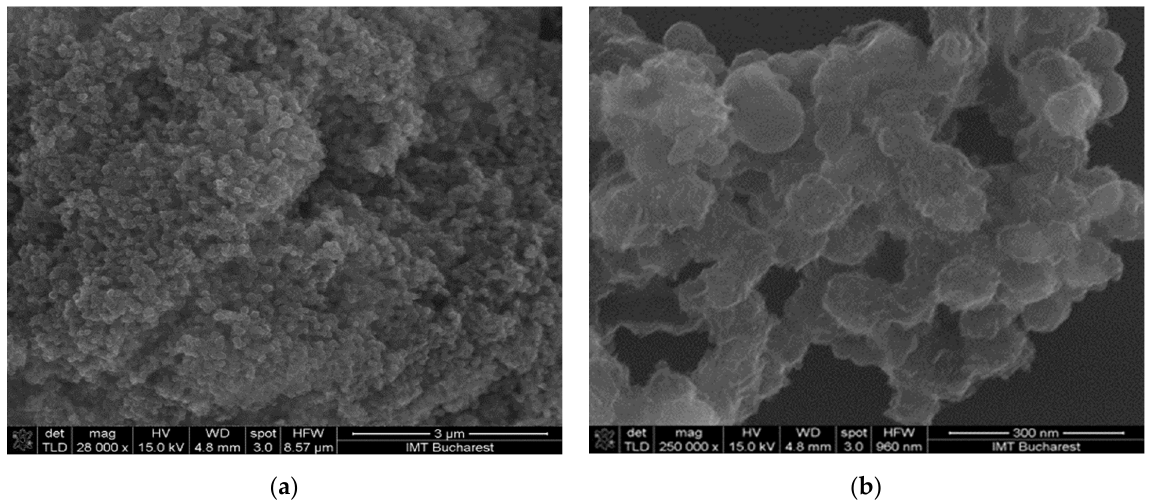
Figure 8. Scanning electron micrographs of the GO/CNHox/PVP at 1:3:1 w/w/w ratio: ( a ) × 28,000 magnification; ( b ) × 250,000